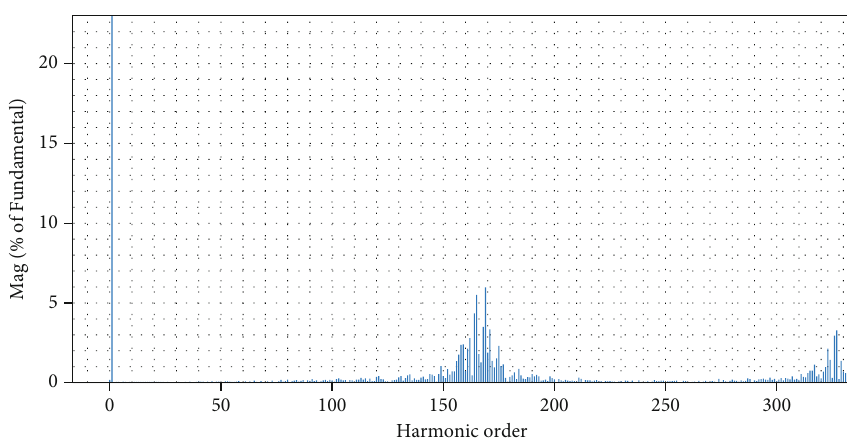
Figure 14: The closed-loop voltage FFT before fi lter.